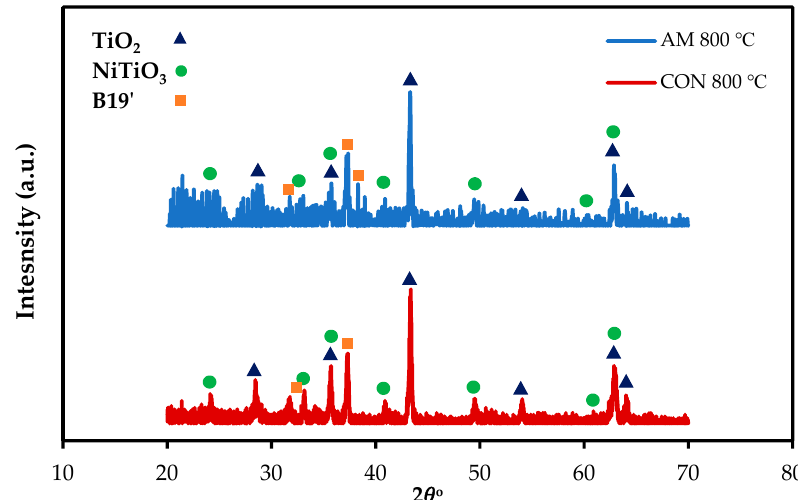
Figure 8. X-ray diffraction patterns of the surface oxide scales on the AM and CON NiTiHf alloys after oxidation at 800 and 900 °C.